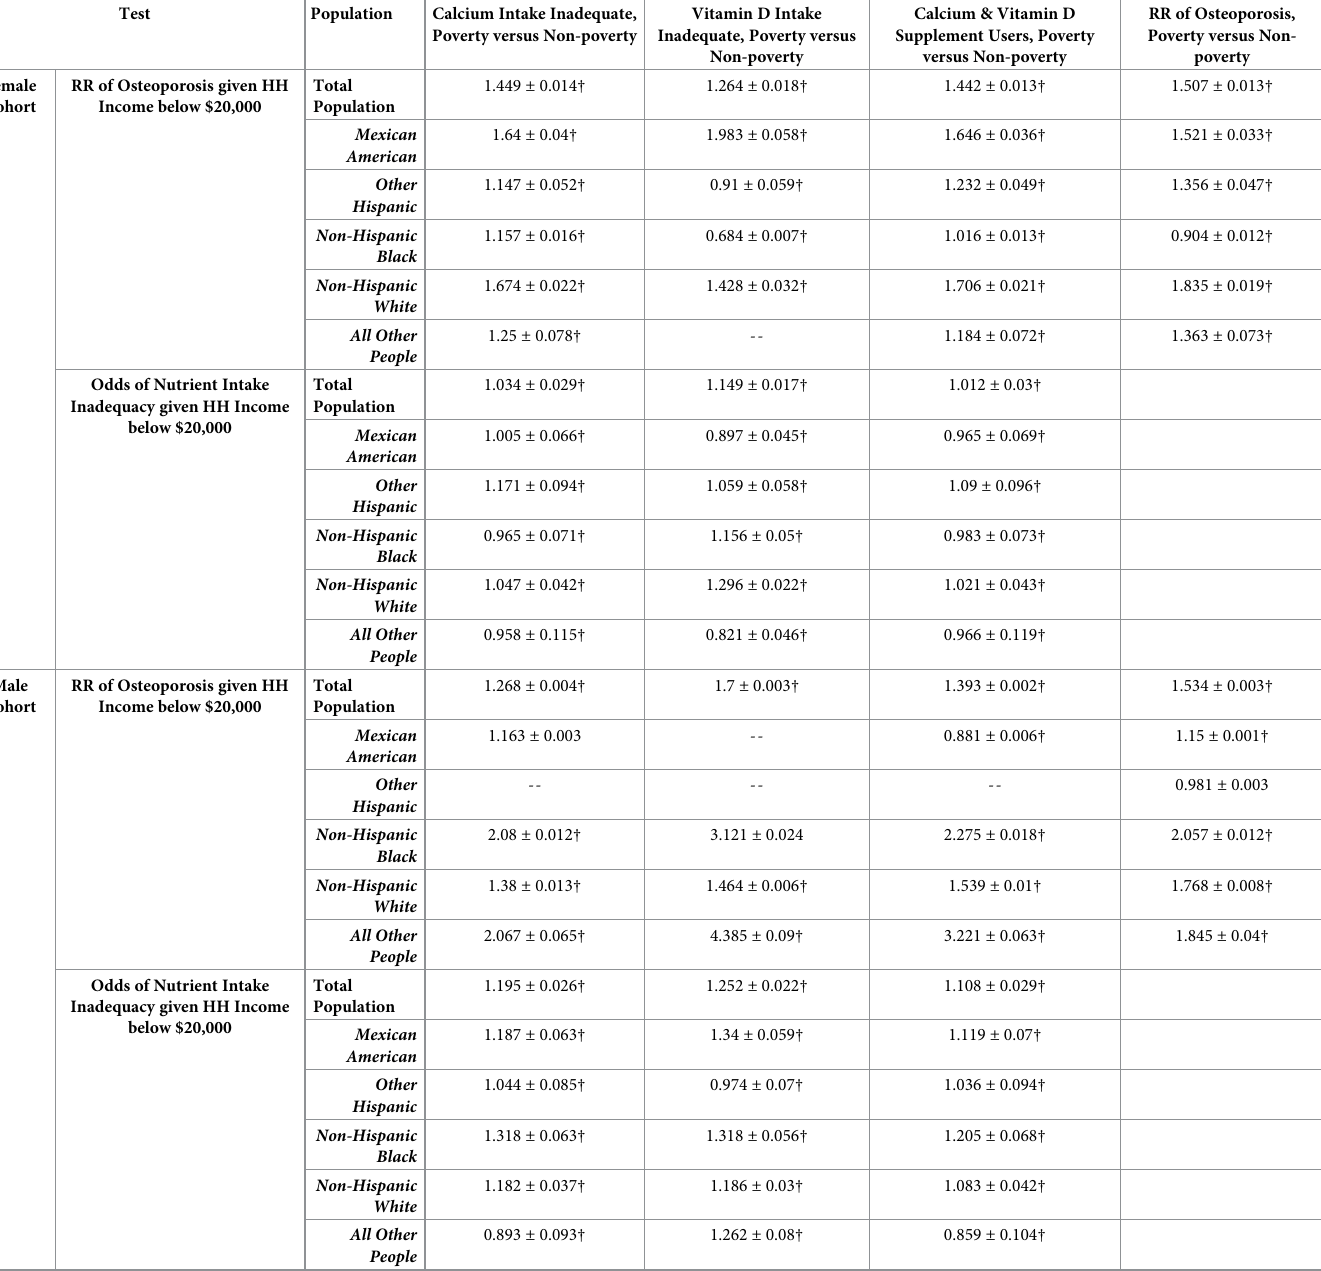
Table 3. Influence of HH income on RR of nutrient intake & osteoporosis with analysis by ethnicity and gender, age 50 and